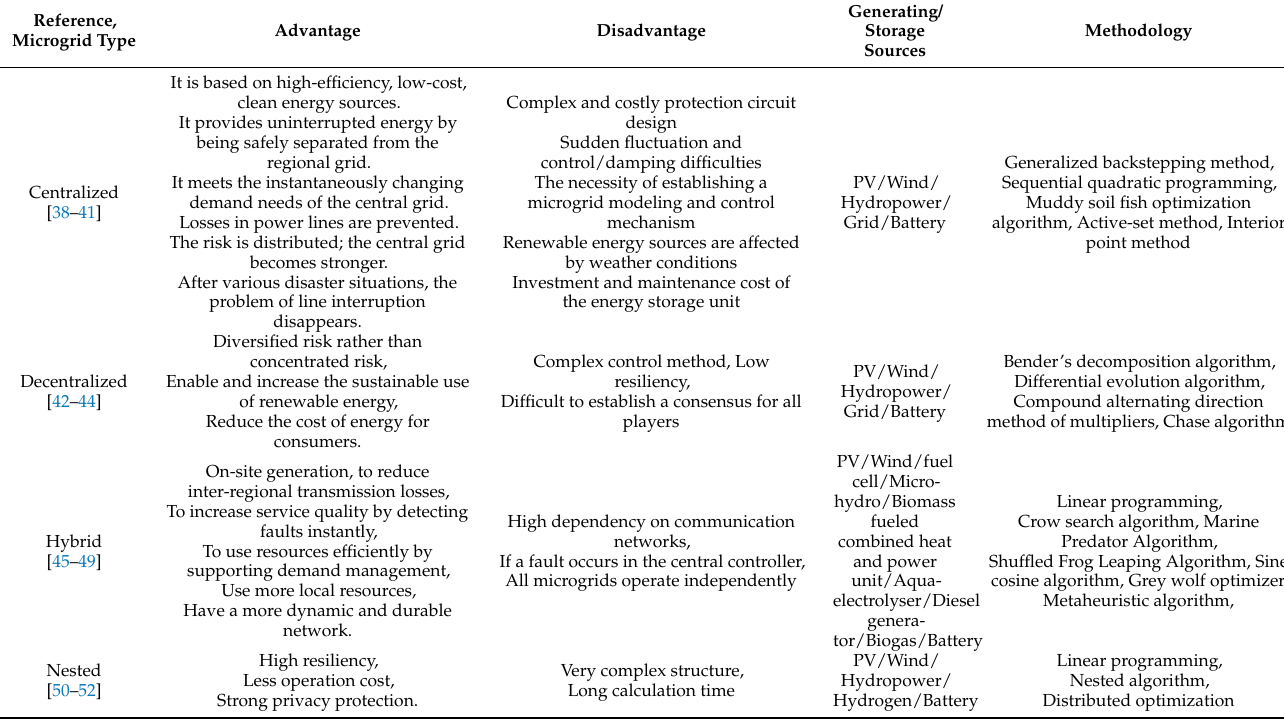
Table 1. Various optimization techniques, sources, and storage devices in microgrid systems.